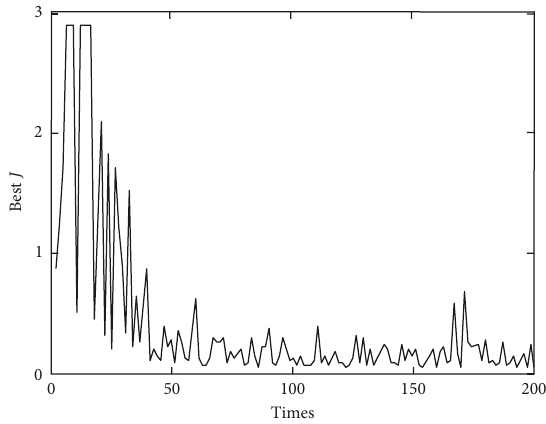
Figure 5: Optimal solution iterative